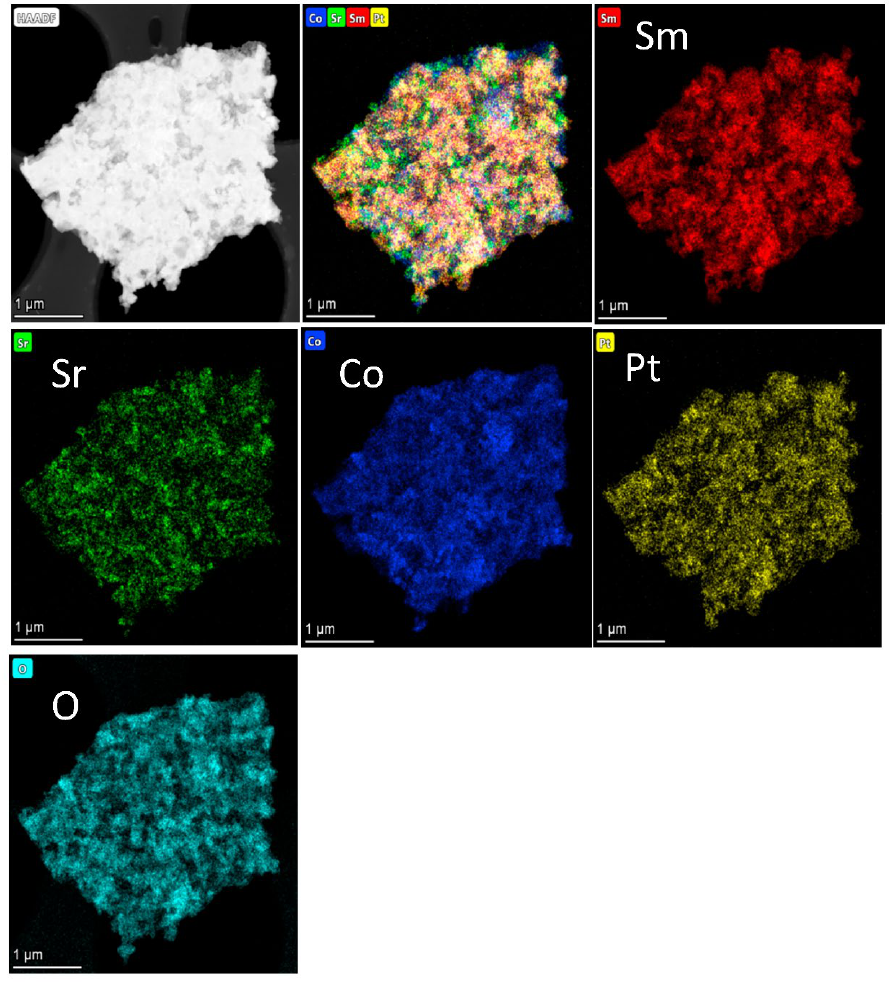
Figure 3. HADDF image and EDS element mappings of Sm, Sr, Co, Pt, and O. The electrocatalytic behavior of perovskites was strongly relied on the valence state of transition metal as well as O anion ordering on catalysts’ surface [30–33]. Figure 4a shows the survey scan of the catalysts for (SmSr) 0.95 Co 0.9 Pt 0.1 O 3 electrocatalysts, indicating the presence of Sm, Sr, Co, and O elements. Moreover, some unknown elements ? were also detected, which might be due to the contamination of tests. Deconvoluted Co 2p and Pt 4f, O1s spectra of the electrocatalyst are shown in Figure 4b,c. Upon deconvolution, Co2p 3/2 (about 780.0 eV) and Co2p 1/2 (about 795.2 eV) peaks corresponding to Co 3+ were observed. Besides, O 1s spectra (Figure 4c) was deconvoluted into two peaks [31]. The first one was a highly oxidative oxygen species (530.4 eV for O 2 2− /O − ) and the second one was hydroxyl group or the surface-adsorbed oxygen (531.4 eV for OH − or O 2 ) [34]. From what has been mentioned in the paper, good OER activity in an alkaline solution might be attributed to O 2 2− /O − on the surface of catalysts [17,35].